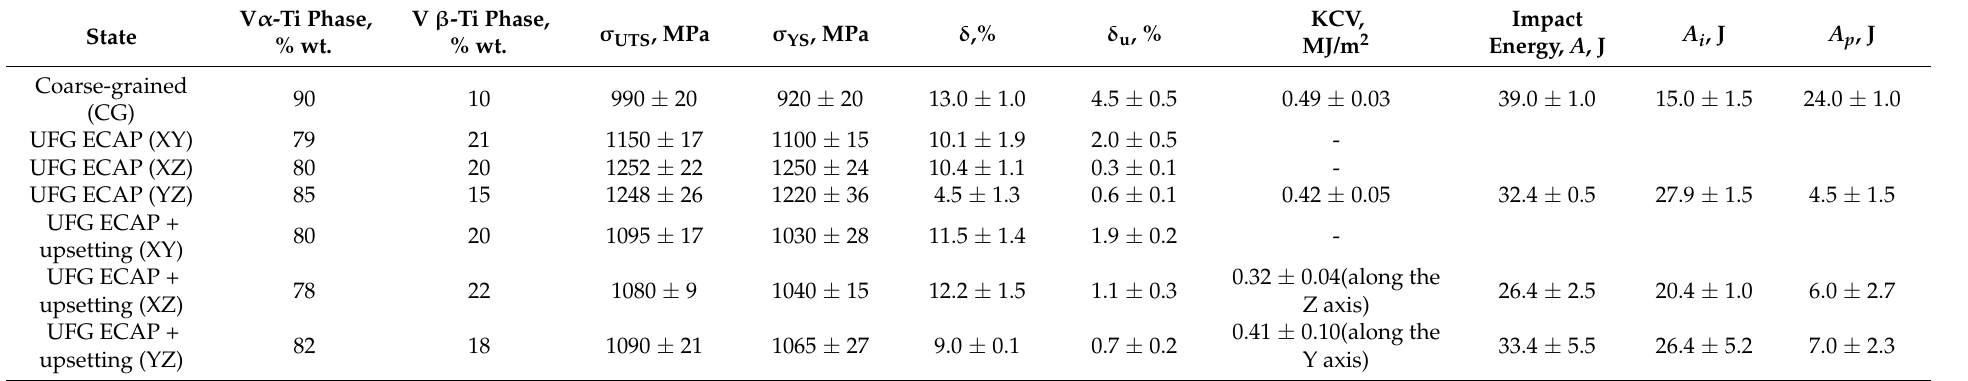
Table 1. Mechanical properties of the Ti-6Al-4V